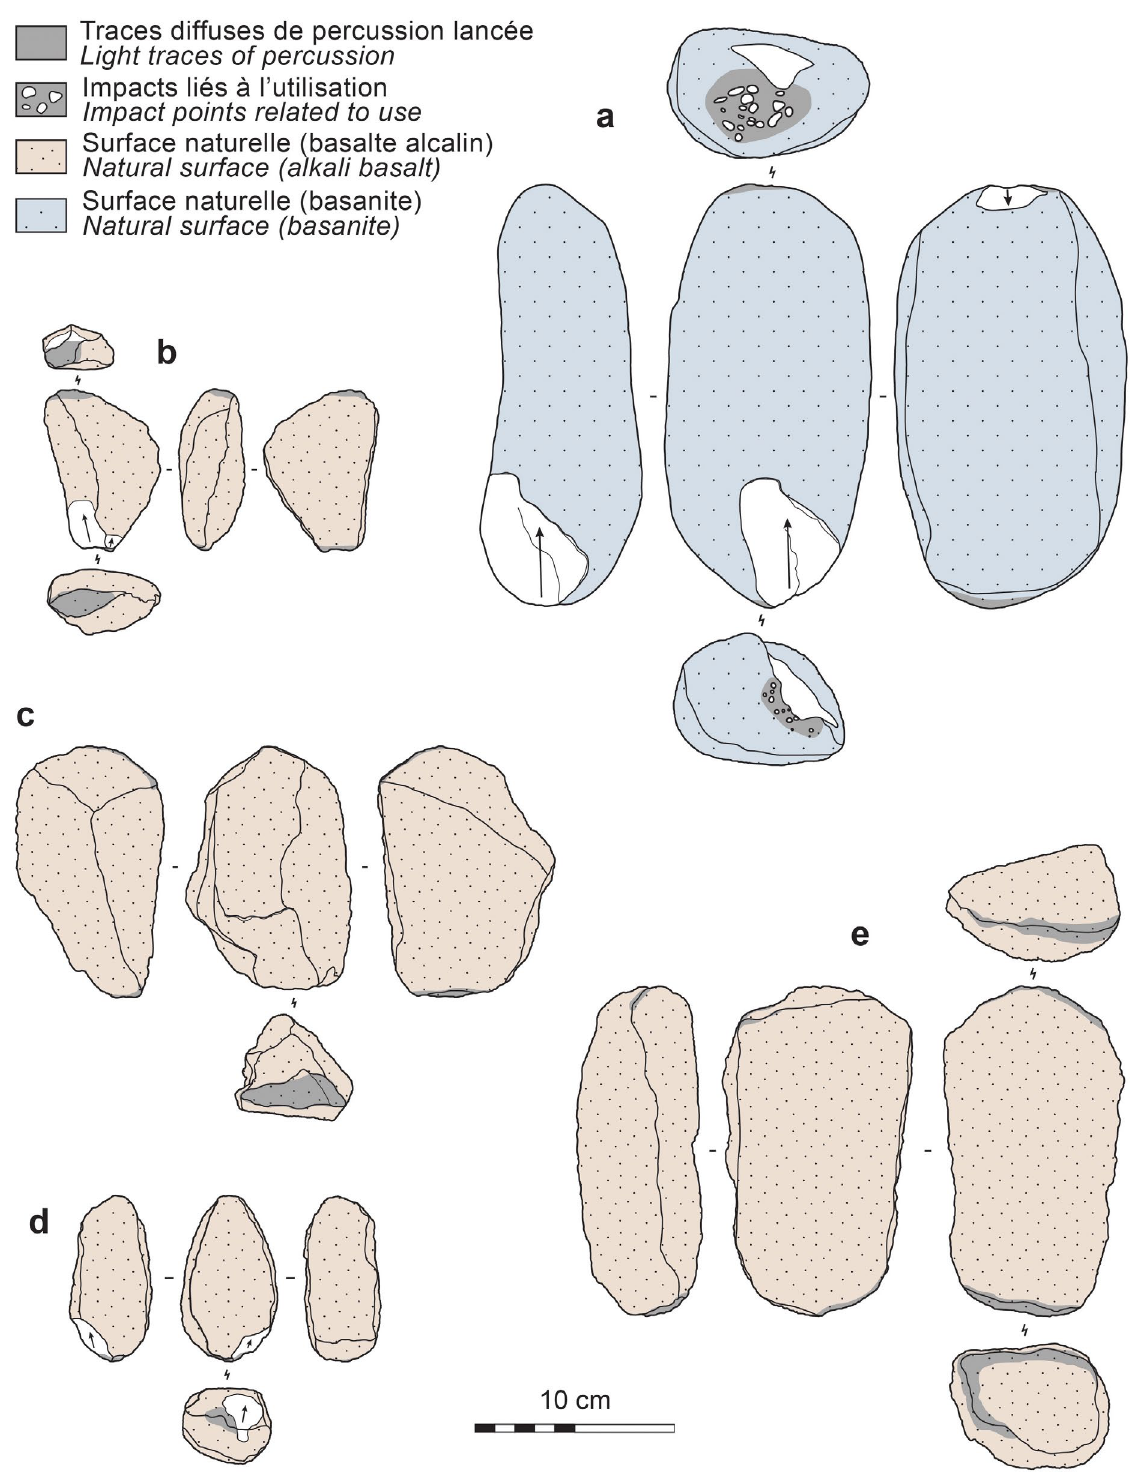
Figure 11. Percuteurs de Tanataetea. Figure 11. Tanataetea stone